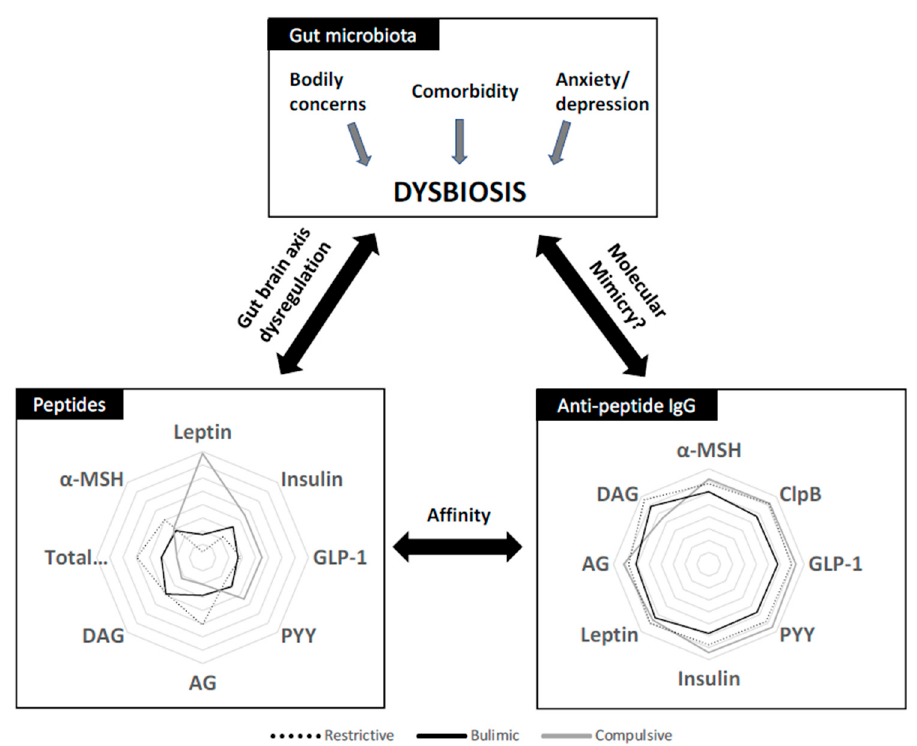
Figure 5. Interaction between gut microbiota, peptides, and immunoglobulin G concentrations in broad categories of ED (restrictive, bulimic, and compulsive).